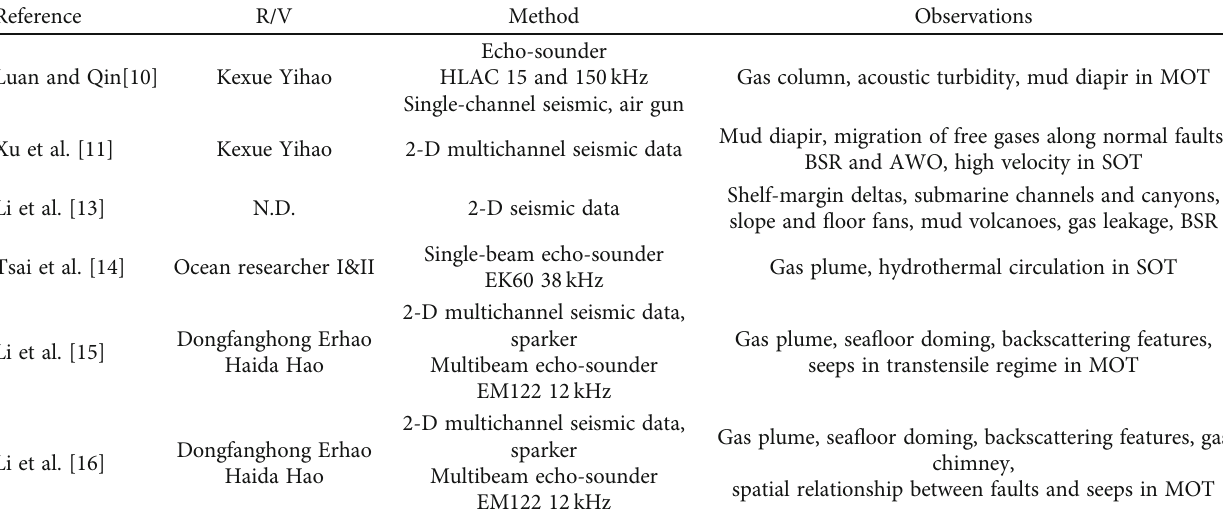
Table 1: Acoustic observations associated with gas seeps in the Okinawa